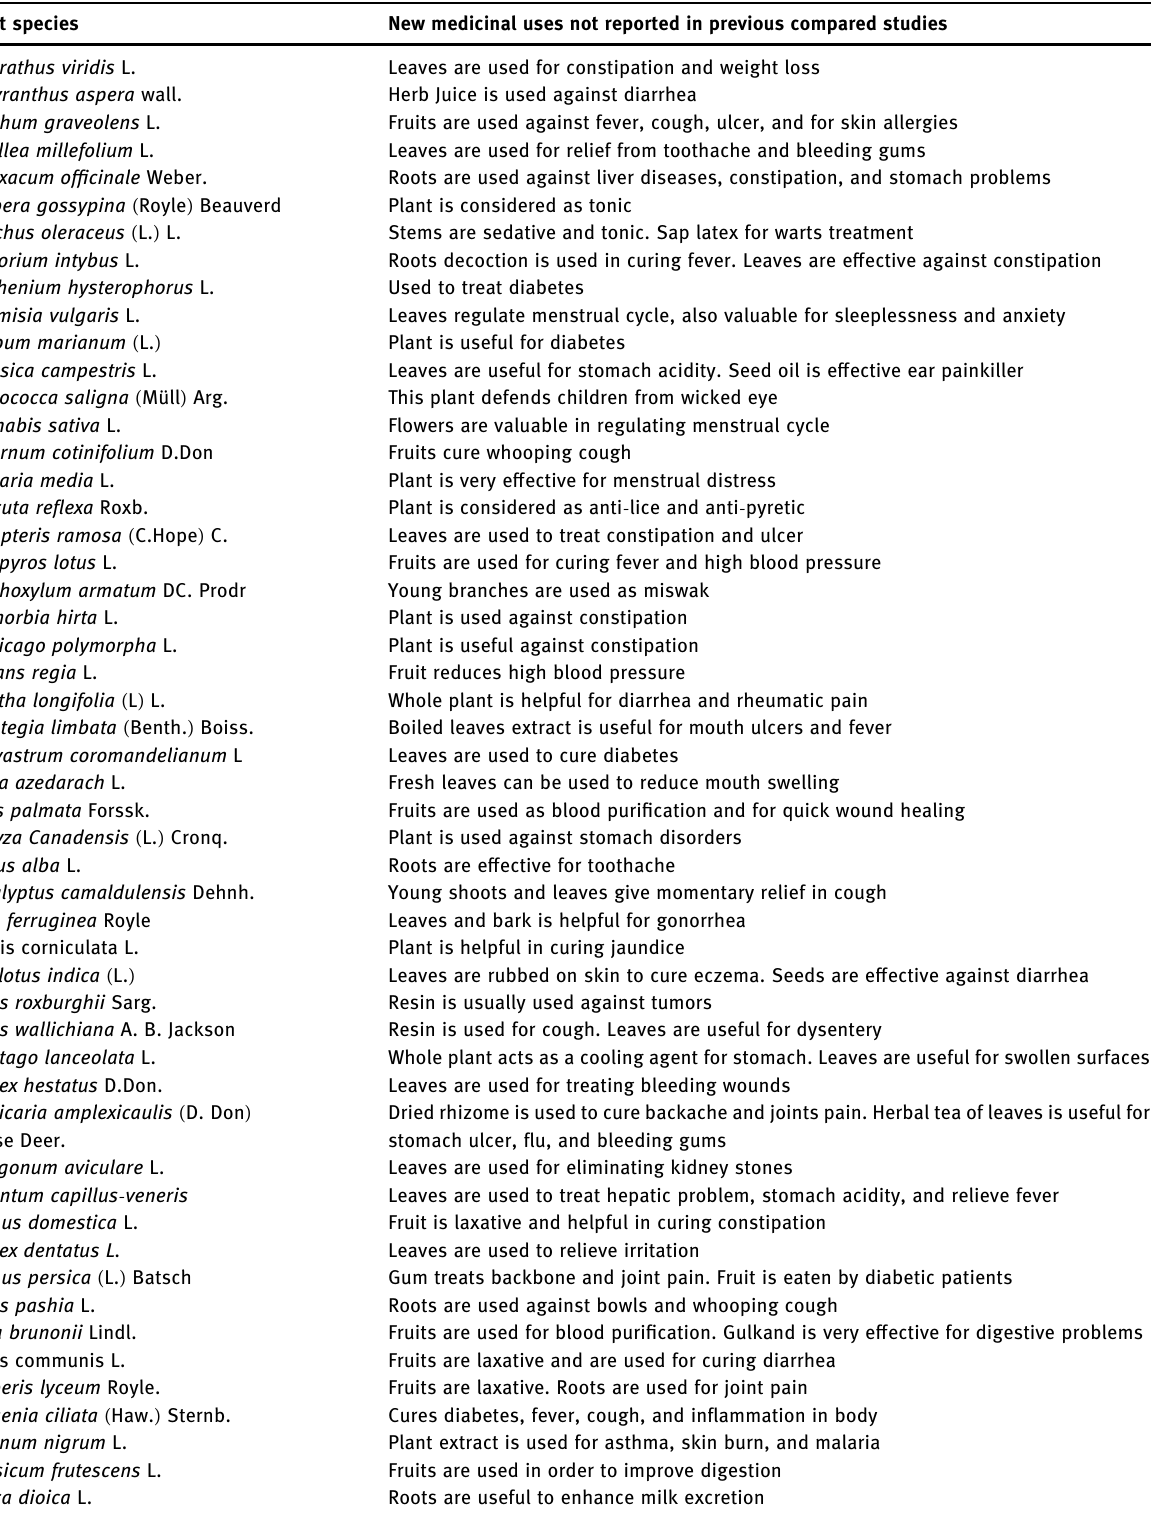
Table 4: New medicinal uses of plant species not reported in previous compared studies Plant